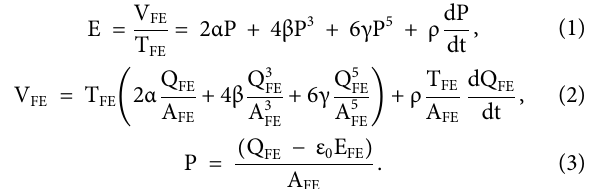
FIGURE 1 | Structure and circuit symbol of the NC2D FET. 2D CIPS is adopted in the top gate stack as the ferroelectric negative capacitance